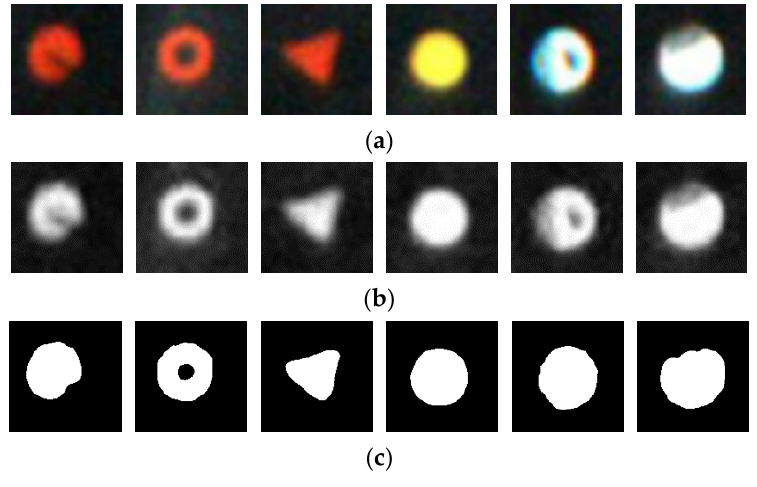
Figure 3. Calculation process of the marking point completeness: ( a ) The marking point image, ( b ) The gray marking point image, and ( c ) The marking point image segmented using the Otsu method.